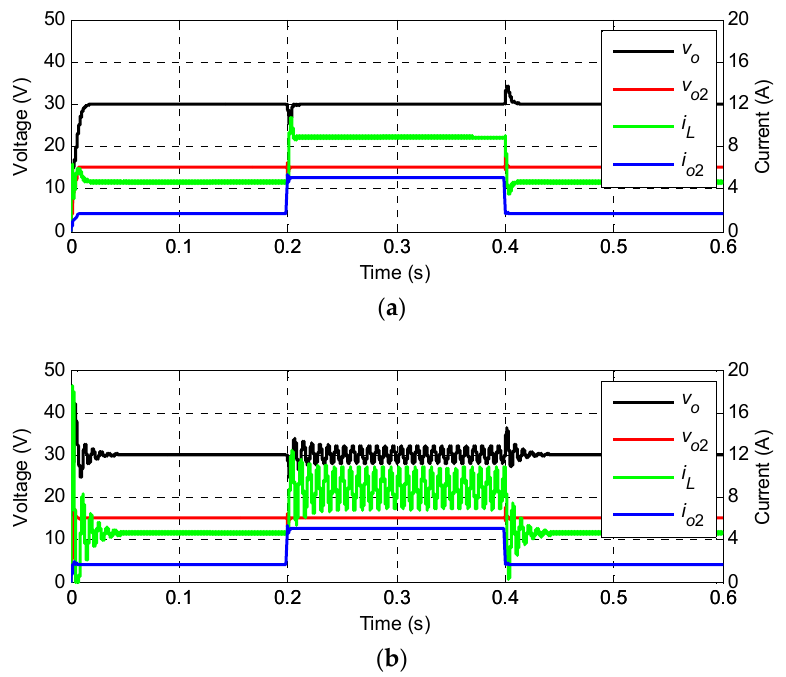
Figure 10. Waveforms of voltage and current of a buck–boost converter with a pure resistive load and a CPL connected in parallel under load disturbances: ( a ) inverse-system decoupling controller; ( b ) conventional double closed-loop controller.